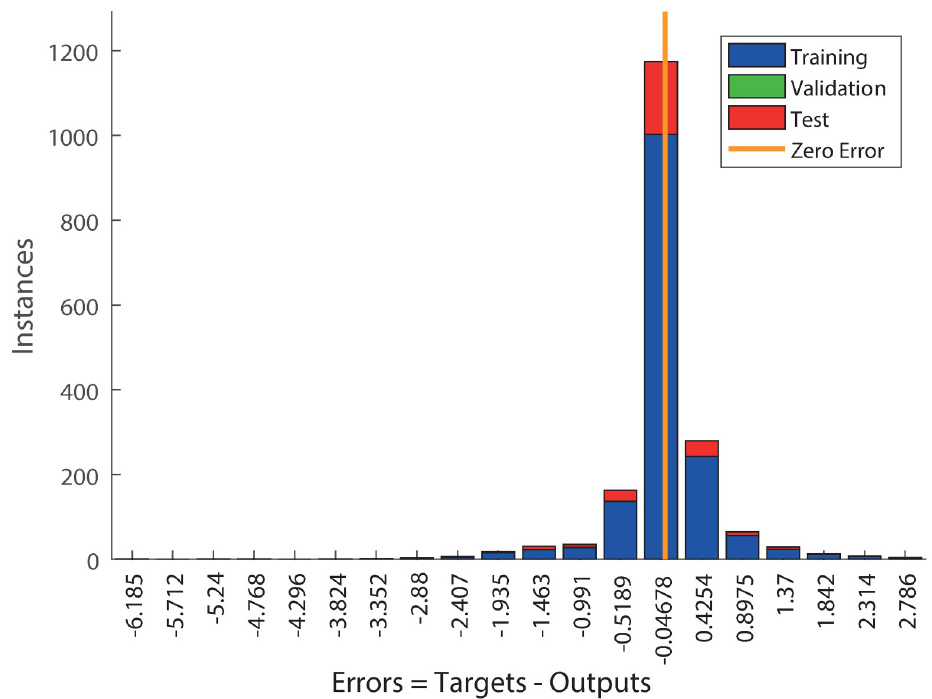
Fig 2. First 100 data vectors from the numerical experiment evaluated for pine. Black cycles indicate value from the point where the diameter was measured to the tip of the tree, blue cross indicates avg depicted as a red dashed line. Horizontal axis [1]—identifier of